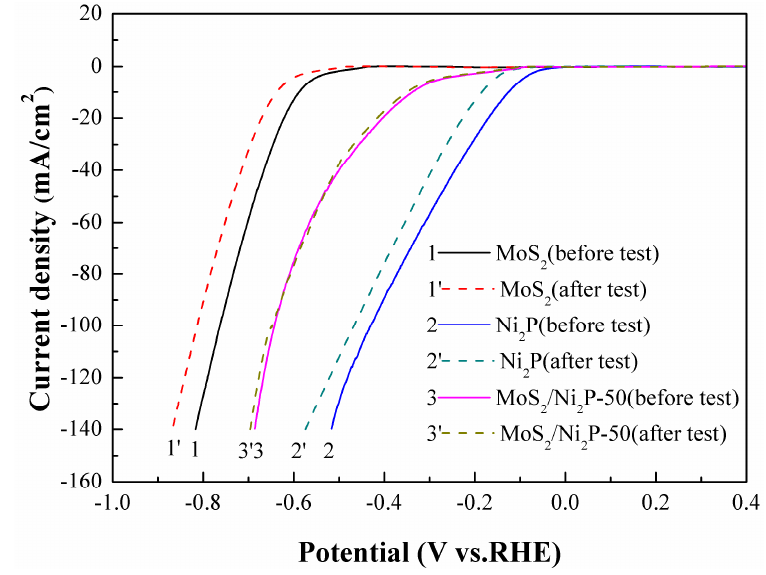
Figure 10. Stability tests for the pure MoS 2 , Ni 2 P, and MoS 2 /Ni 2 P-50 hybrid. Scan rate: 50 mV/s, potential window: − 1.0 to 0.4 V (vs. RHE).